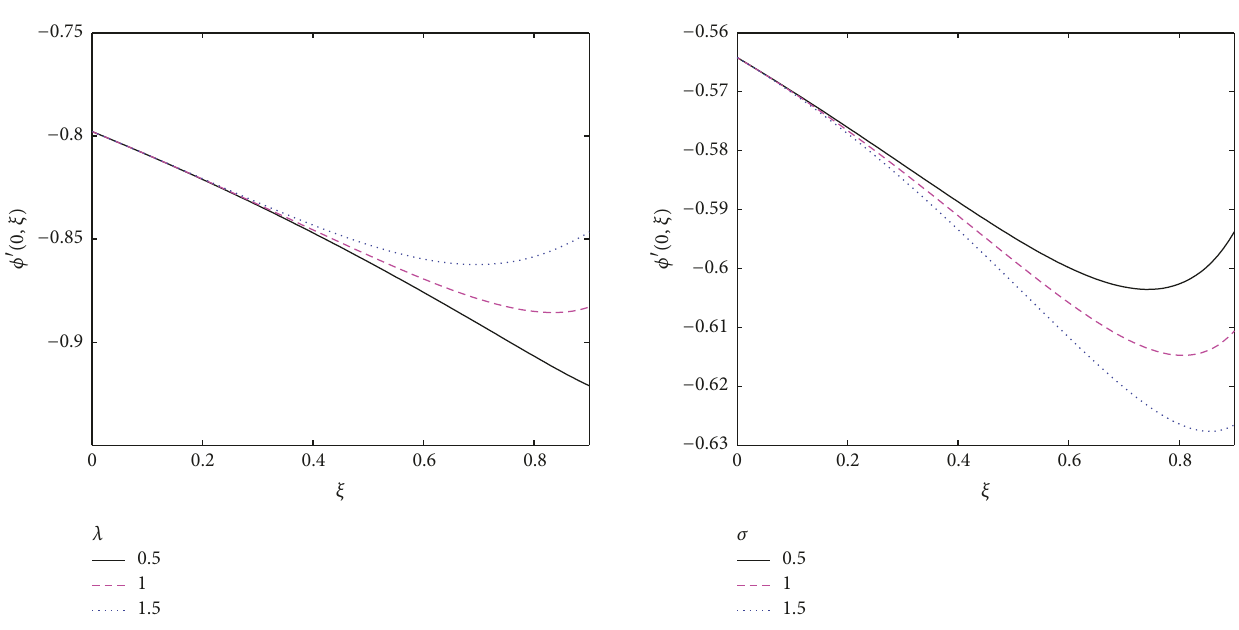
Figure 24: Effect of 𝜆 on 𝜙 󸀠 (0, 𝜉) ( 𝜎 = 𝛾 = 0.5, Pr = 3, Sc = 2, ℏ = −0.5 ).